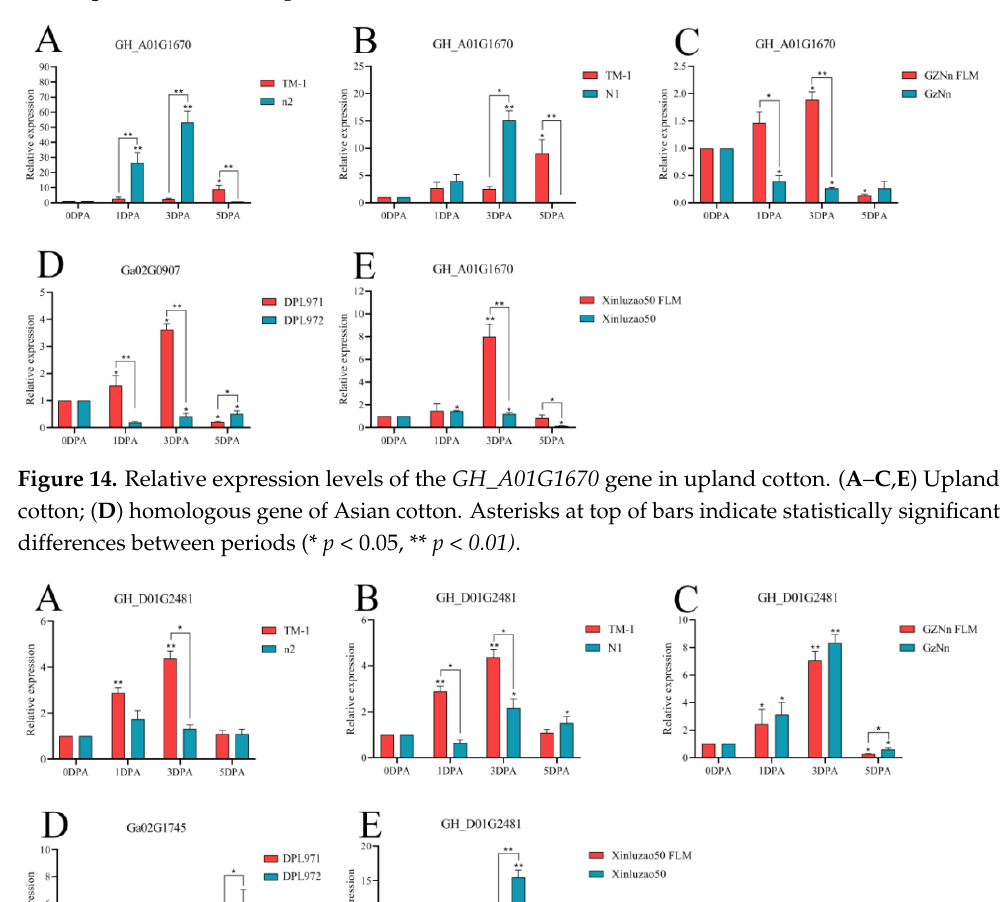
Figure 14. Relative expression levels of the GH_A01G1670 gene in upland cotton. ( A – C , E ) Upland cotton; ( D ) homologous gene of Asian cotton. Asterisks at top of bars indicate statistically significant differences between periods (* p < 0.05, ** p < 0.01).